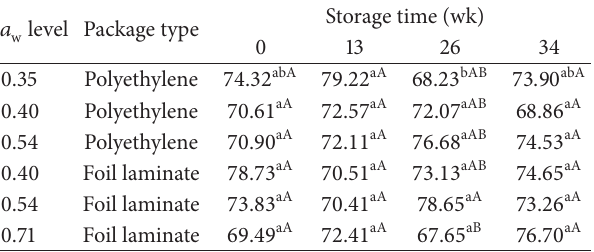
Table 3: Changes in 𝑎 ∗ ( ± , green/red) color values of dehydrated levels and in different taro slices stored at different 𝑎 w materials 1 .